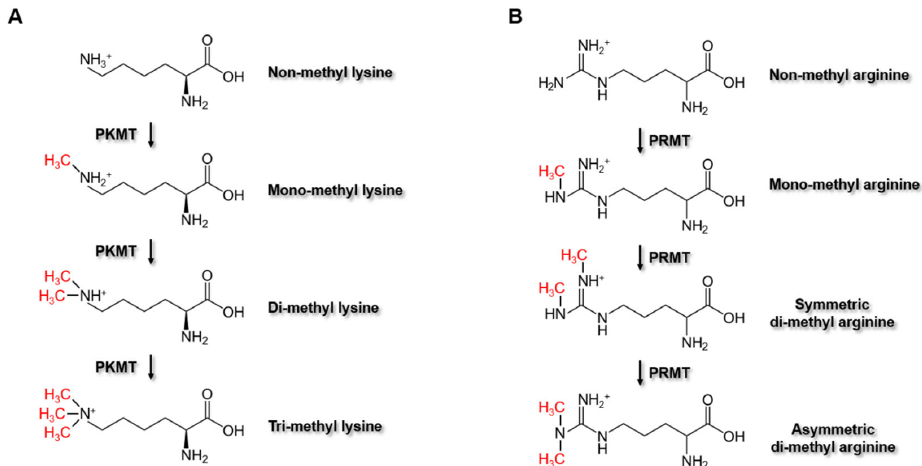
Figure 3. Methylation reactions by PKMT and PRMT. ( A ) Chemical reactions of PKMT-mediated methylation. PKMTs catalyze the methylation at lysine residue of proteins, producing mono-methyl lysine, di-methyl lysine, and tri-methyl lysine. ( B ) Chemical reactions of PRMT-mediated methylation. PRMTs catalyze the methylation at arginine residue of proteins, producing mono-methyl arginine and either of symmetric di-methyl arginine or asymmetric di-methyl arginine. PKMT, protein-lysine methyltransferases; PRMT, protein-arginine methyltransferases.